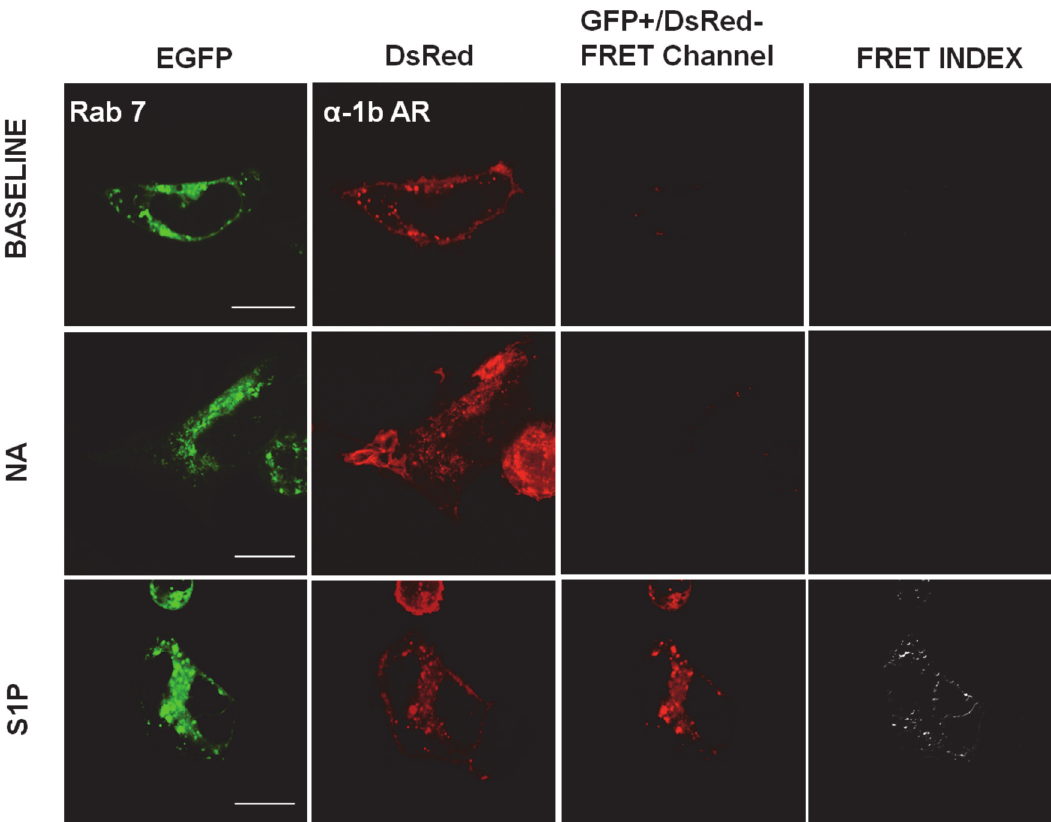
Fig 7. α 1B -Adrenergic receptor-Rab 7 interaction. Images of cells coexpressing α 1B -adrenergic receptors tagged with the DsRed fluorescent protein ( α 1B -AR) and Rab 7 tagged with the enhanced green fluorescent protein (EGFP). Scale bars: 15 μ m. Other indications as in Fig.